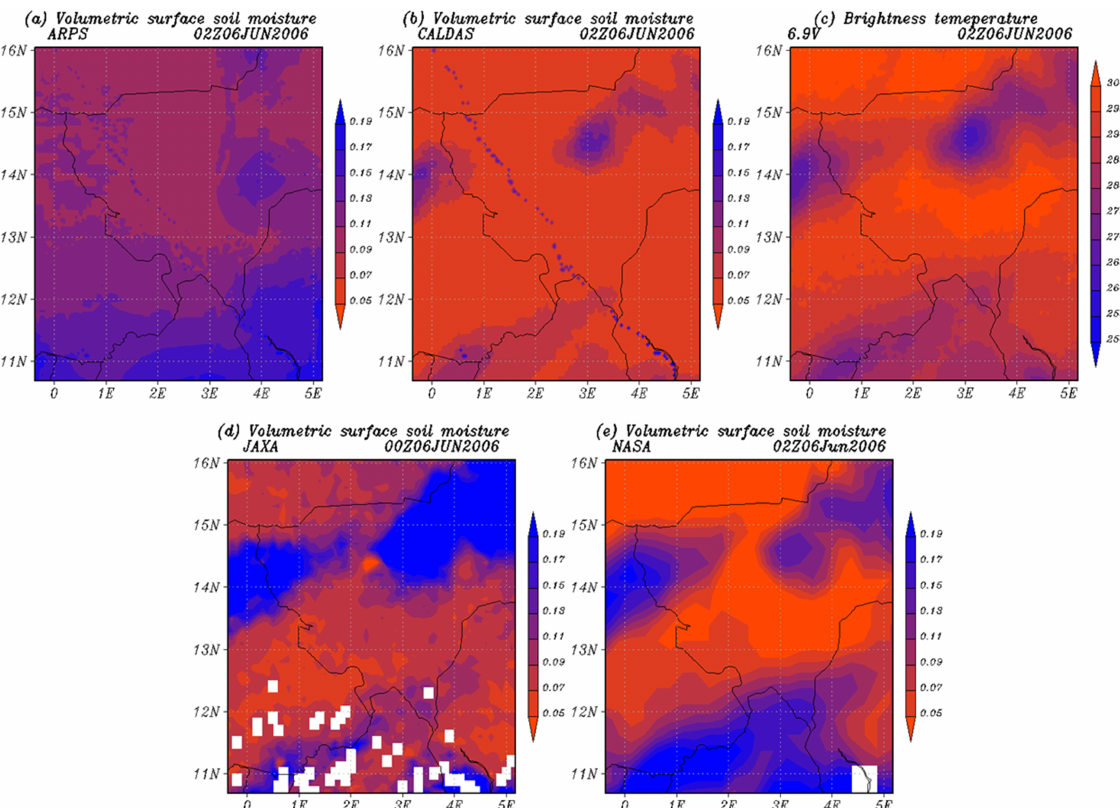
Figure 3. Spatial distribution of volumetric surface soil moisture (m 3 /m 3 ) at 0200 UTC on 6 June 2006; ( a ) ARPS; ( b ) CALDAS; ( c ) dvanced Microwave Scanning Radiometer (AMSR)-E brightness temperature (K) observed at 6.9 GHz; ( d ) Japan Aerospace Exploration Agency (JAXA) product; and ( e ) National Aeronautics and Space Administration (NASA) product,